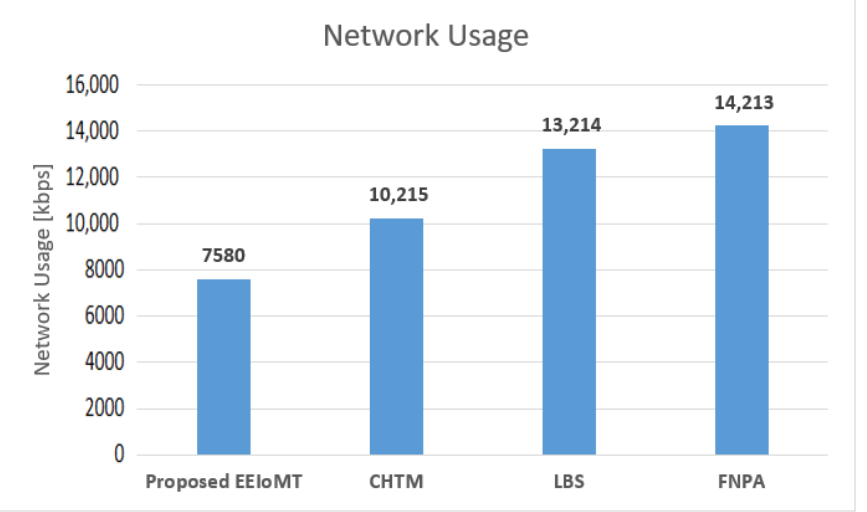
Figure 6. Comparison of Network Usage.